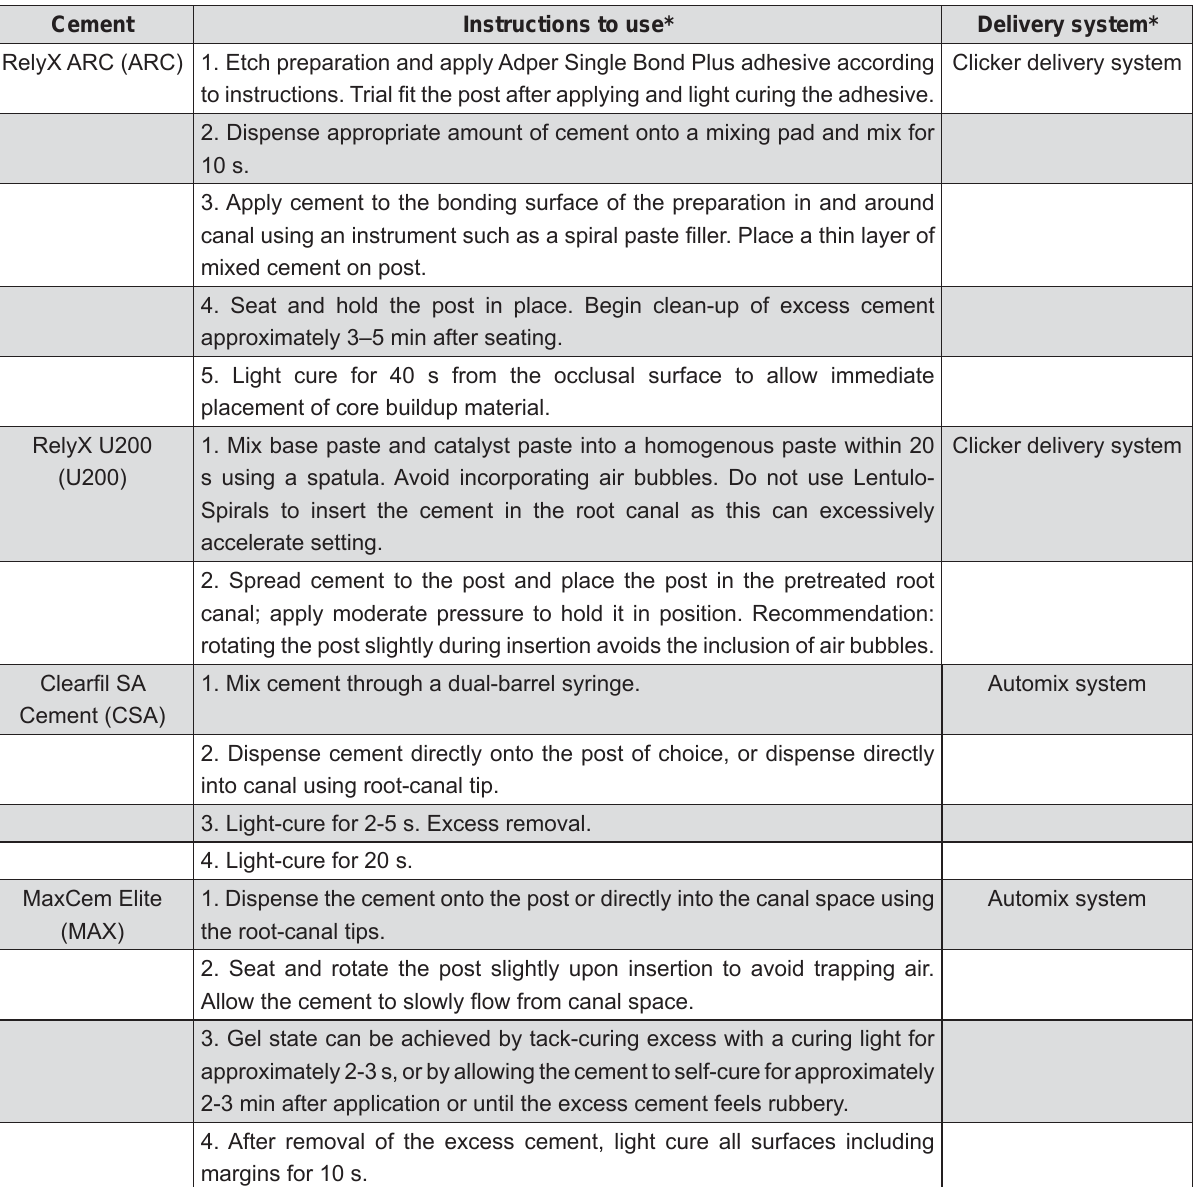
Figure 2- Application modes of the cements